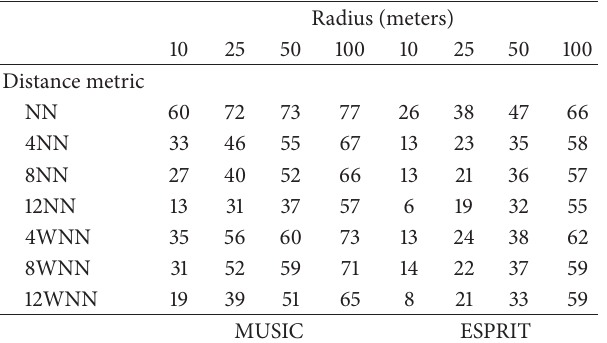
Table 8: Number of “hits” within given radius to actual location for each distance metric out of 100 trials. SNR = 15 dB; number of antennas = 12; oversampling factor = 2; distance-threshold = 0.2, Scenario